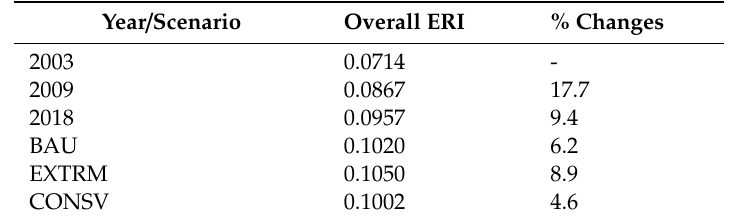
Table 12. Overall ecological risk index changes (%) from 2003 to 2027 (BAU: Business as usual; EXTRM: Extreme; CONSV: Conservation).